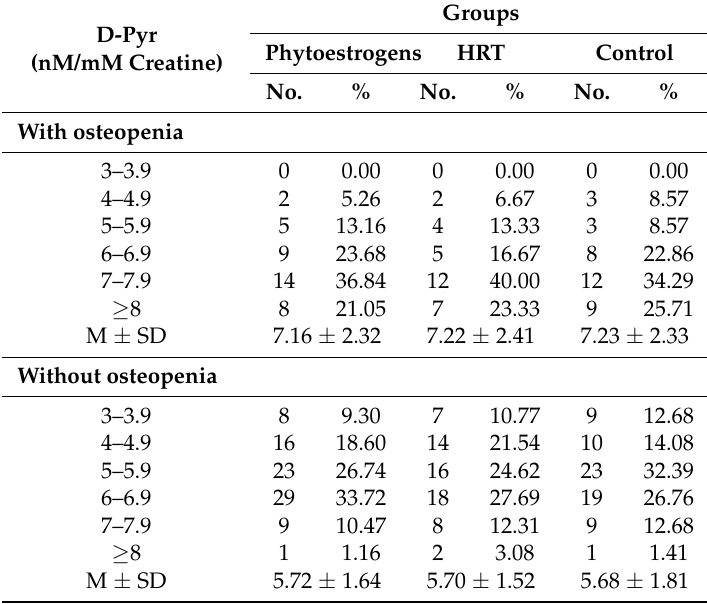
Table 7. The distribution of cases according to D-Pyr values (nM/mM creatine) and depending on T-score.